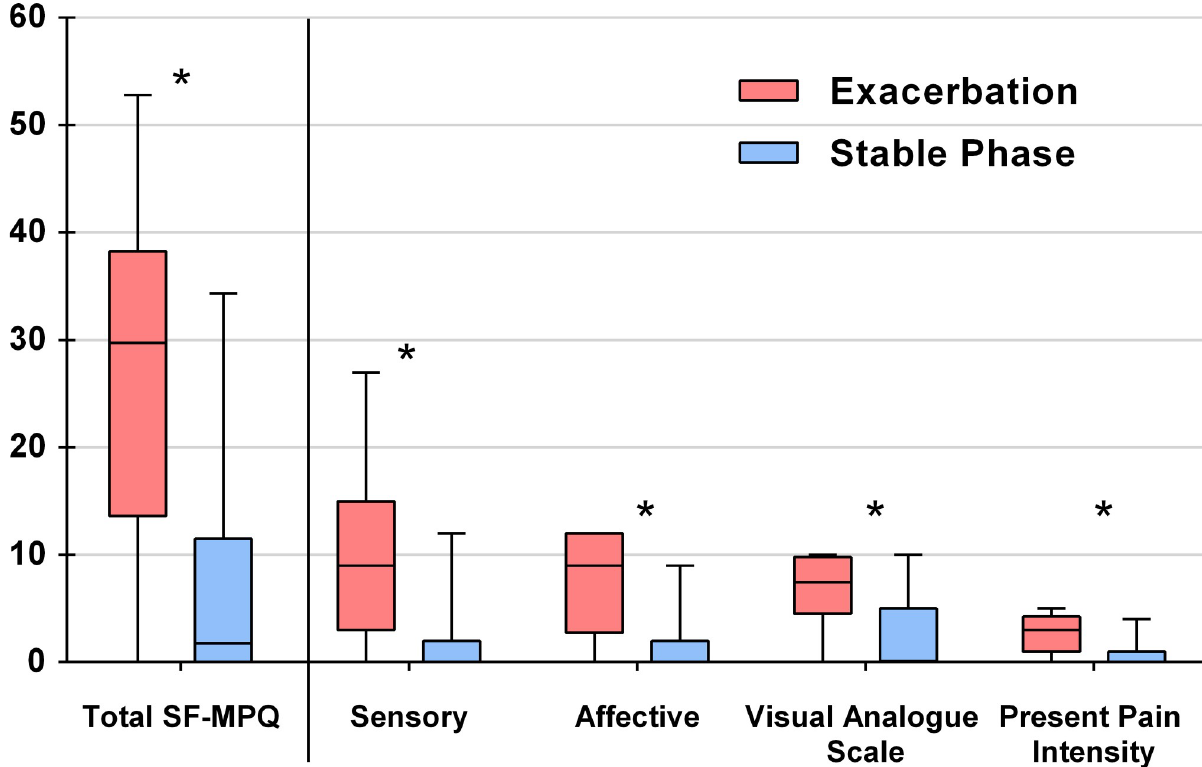
Fig 2. Short Form McGill Pain Questionnaire (SF-MPQ) and its components during the exacerbation and stable phases. � p-values are < 0.001 for all comparisons between the exacerbation and stable phases. Results are displayed on box-and-whisker plots, showing the intensity of reported pain levels with medians, interquartile ranges and